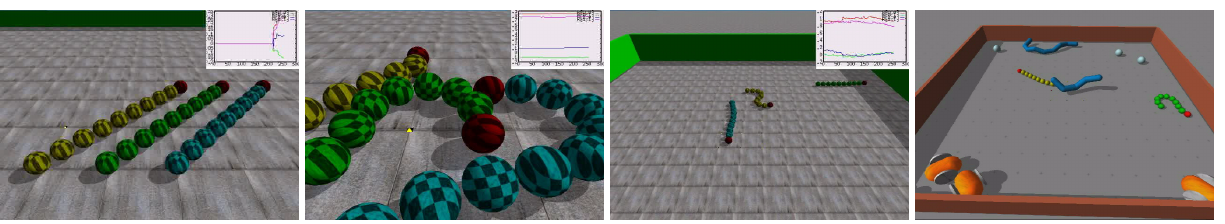
Figure 7. Images of skidding snakes. Far left: Initial position in an experiment with three skidding snakes. Left: Close view of three skidding snakes in the beginning of an experi- ment. Right: Later on in the experiment: Two snakes are in the rotational mode where the bodies become stiff like sticks due to the gyroscopic effects of the rapidly rotating spheres of the body. The third is in z-shape with the tail passively swaying around. Far right: A group of interacting self-organized creatures under homeokinetic control. The three white balls are not actuated. The systems try different modes of behavior (including the rotational mode of the skidding snake) even under perturbations by other active agents. See also the videos